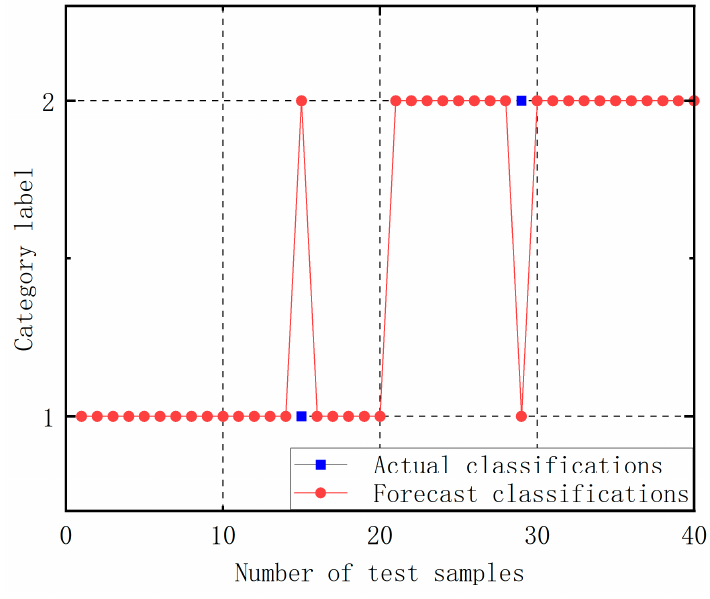
Figure 8. Anchor smash fault identification results based on the EEMD–Volterra–SVM method.